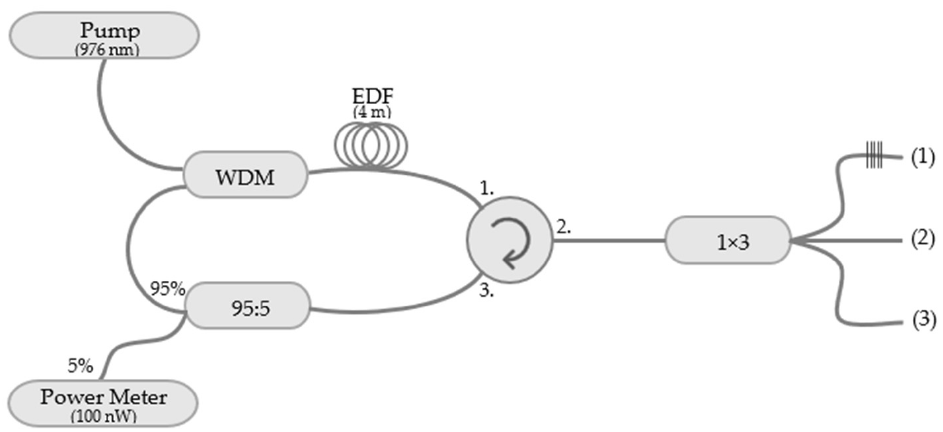
Figure 1. Experimental setup of the EDFRC proposed for paracetamol concentration measurements. Coupler output ports: (1) FBG; (2) reference and (3) sensing head. Coupler output ports: (1) FBG; (2) reference and (3) sensing